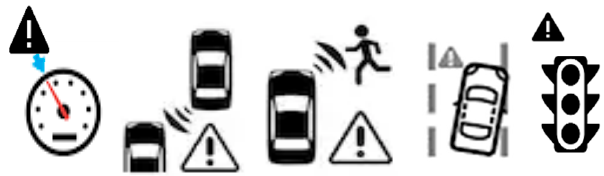
Figure 10. Basic vehicle-to-vehicle (V2V) road safety.